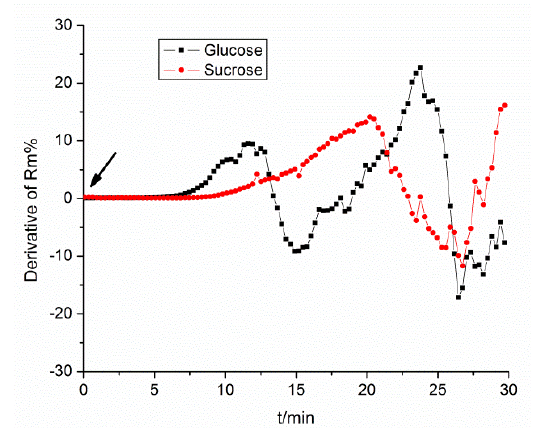
Fig. 6: Comparison of the derivative of Rm% for glucose and sucrose.